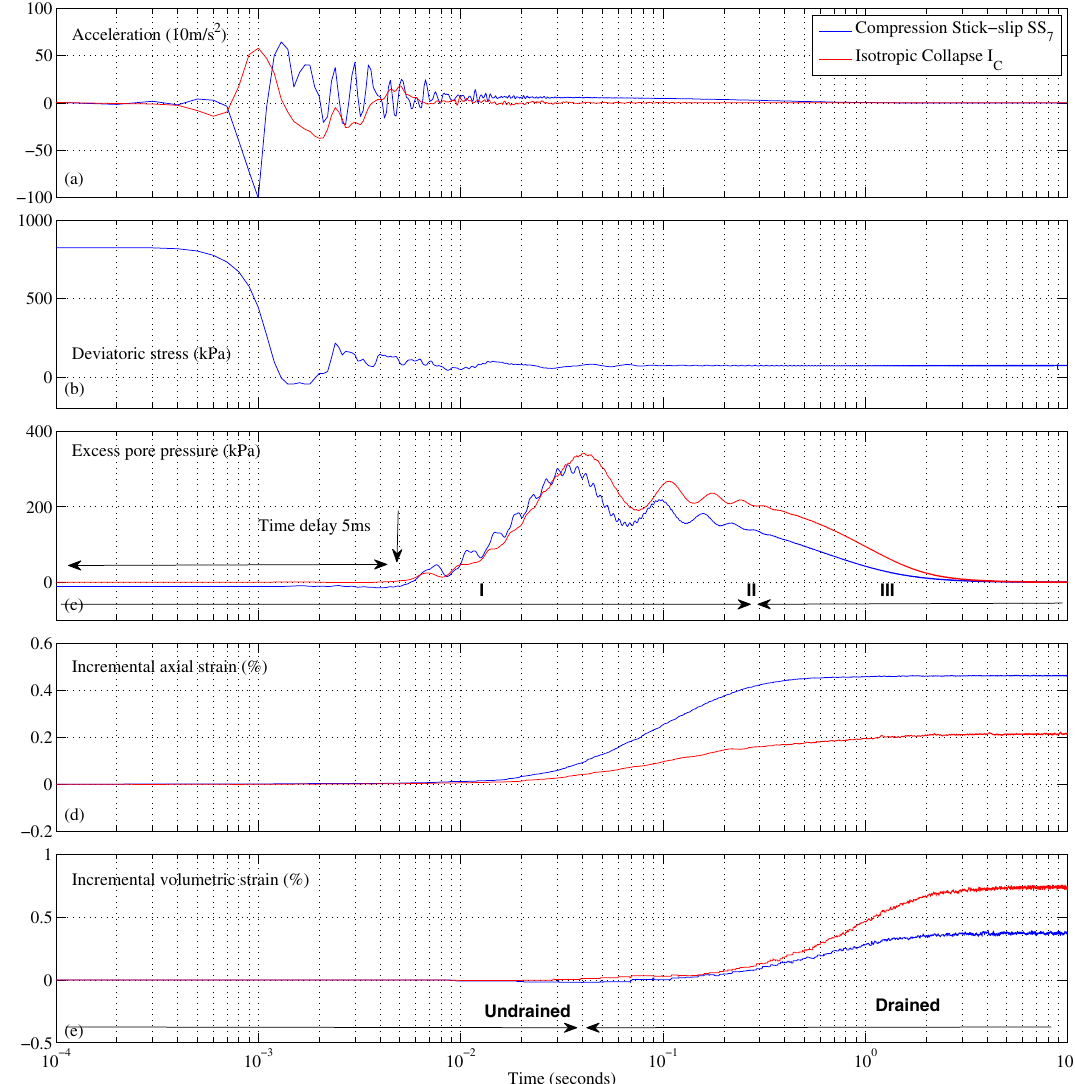
Figure 2. Typical temporal evolution of one representative stick-slip event induced by compression under drained conditions (blue) picked on the deviatoric stress plateau and one isotropic collapse event (red) during the triaxial test at 400 kPa of confining stress. From top to bottom: vertical top cap acceleration, deviatoric stress, excess pore fluid pressure, incremental axial strain and incremental volumetric strain. The excess pore pressure corresponding to the stick-slip event is below the constant cell pressure of 400 kPa, indicating a nonliquefaction event during which the effective stress remains positive. In isotropic compression, the vertical acceleration of the sample top cap is magnified by a factor of